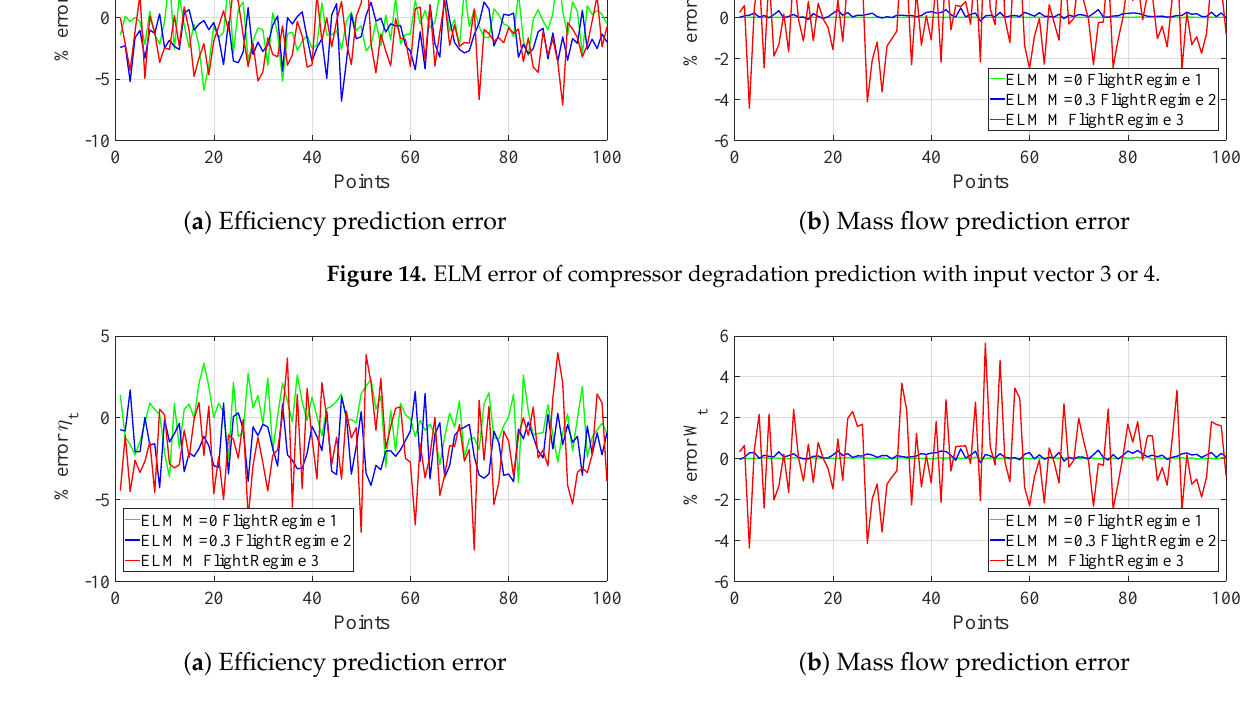
Figure 15. ELM error of turbine degradation prediction with input vector 3 or